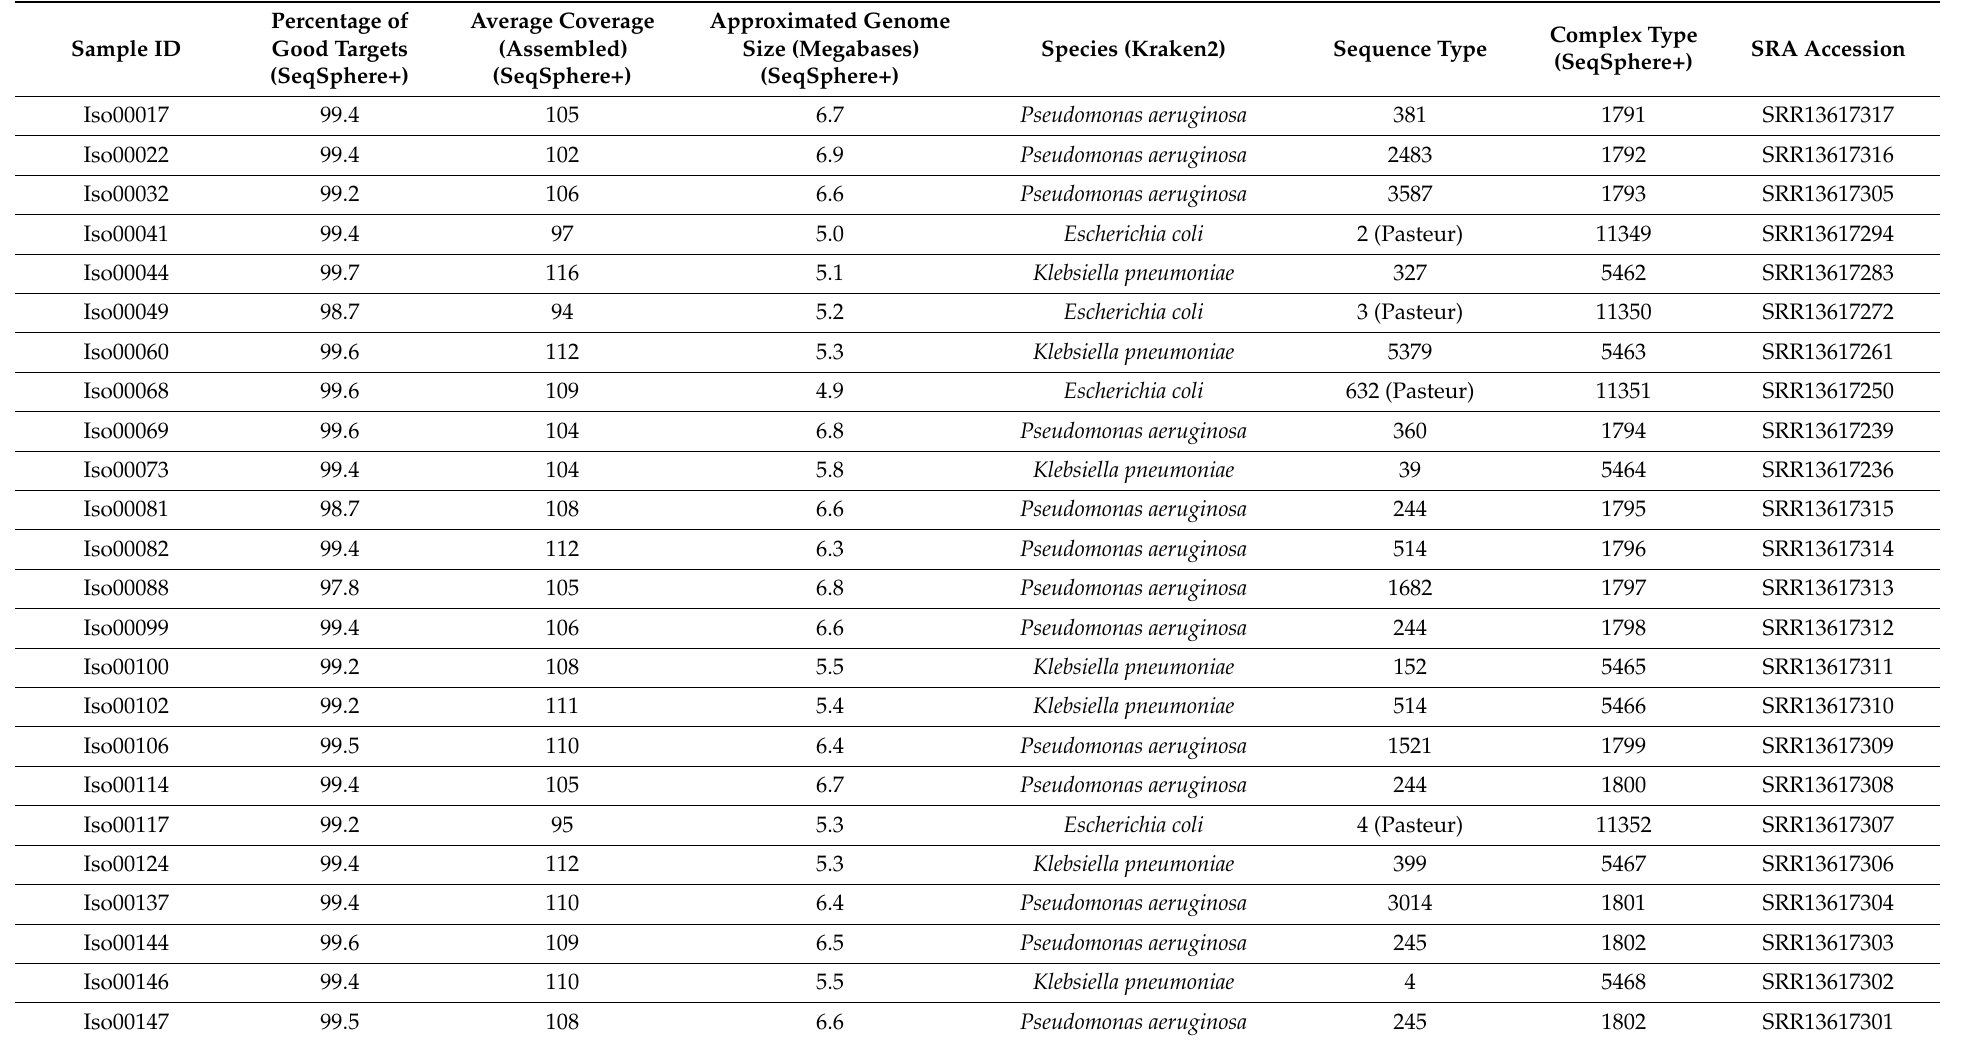
Table A11. Details on the strain-specific short-read archive (SRA) accession